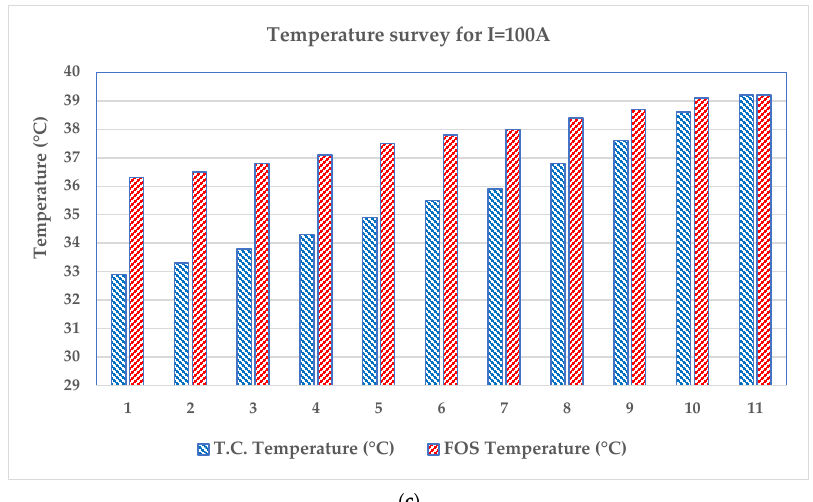
Figure 13. The temperature measured by the thermocouple and the FOS for two different values of intensity, ( a ): I = 50 A, ( b ): I =100 A and ( c ): comparative values of temperatures provided by the FOS and thermocouple for I = 100 A.